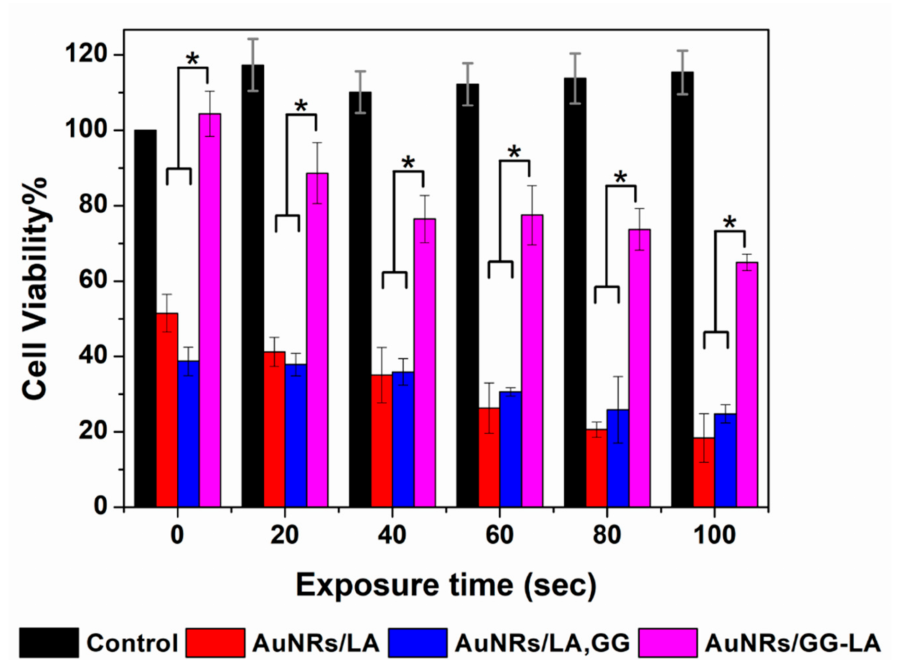
Figure 8. Cell viability of HCT116 line incubated with DMEM (black), AuNRs / LA (red), AuNRs / LA, gellan gum (GG) (blue) (Au concentration: 5 µ g · mL − 1 ) and AuNRs / GG-LA (fuchsia) after laser treatment (810 nm, 10 × 10 − 3 W / mm 3 , and 100 s), versus irradiation time. Statistical significance (Student’s two-tailed t test): * p <